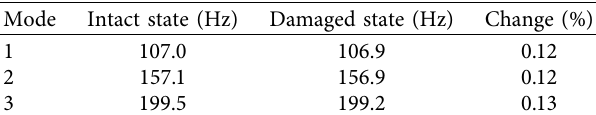
Table 4: Change of natural frequencies due to damage.